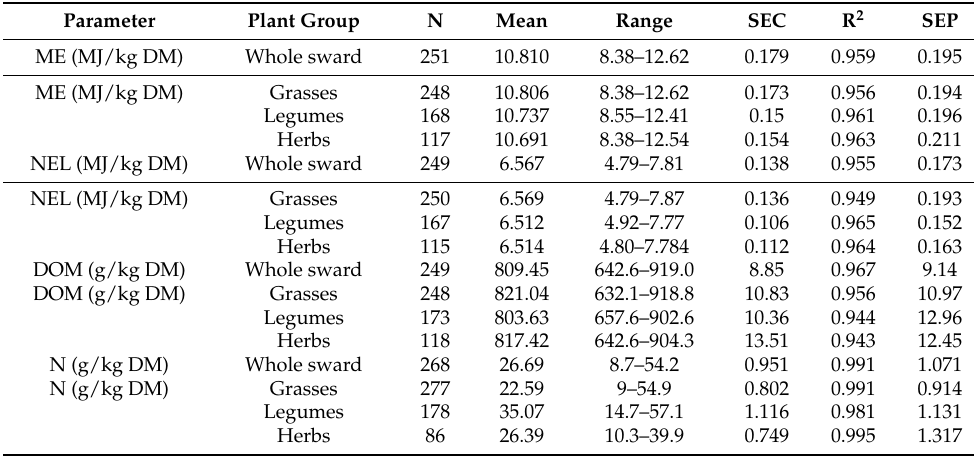
Table A1. Statistical data of the NIRS calibration and validation (SEC, standard error of calibration; SEV, standard error of prediction) for the relevant quality parameters by plant